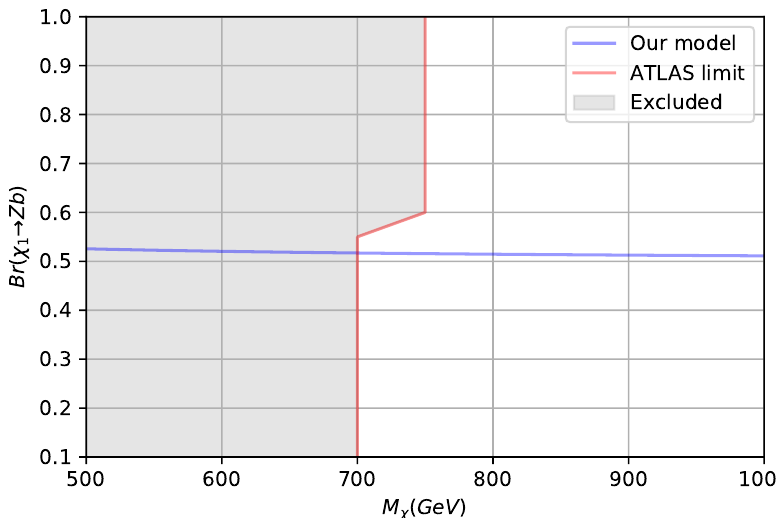
Figure 8. Projected ATLAS limit [98] on vector-like quark mass from (cid:31) 1 ! Zb demonstrates a lower limit on m (cid:31) , with (cid:12)xed mixing Yukawa Y b = 1